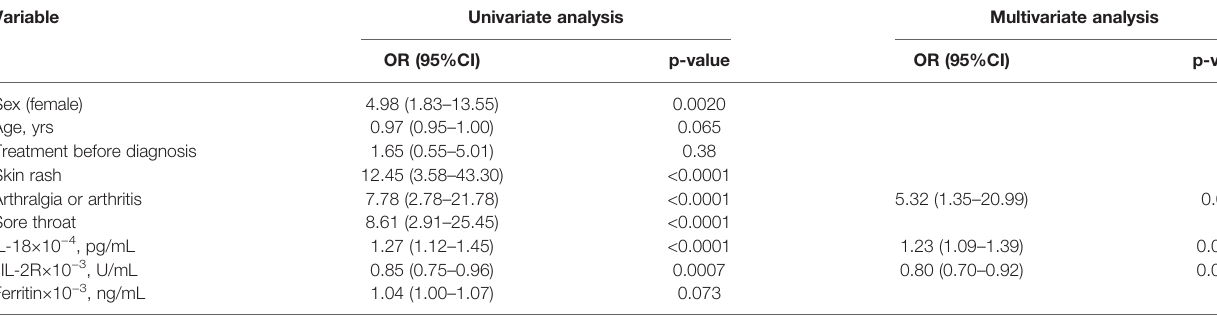
Age, sex, and treatment before diagnosis were adjusted in the multivariate analysis. The adjusted odds ratio (OR) was calculated by multiplying the estimated regression coef fi cient by 10,000 for IL-18 and 1,000 for sIL-2R and ferritin. OR, odds ratio; 95%CI, 95%con fi dence interval; IL, interleukin; sIL-2R, soluble interleukin 2